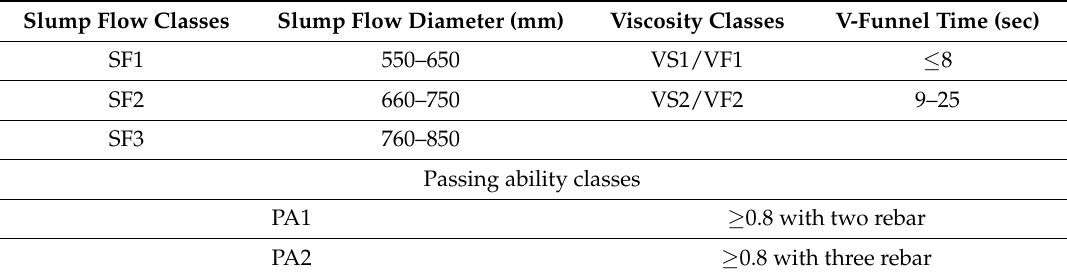
Table 3. Recommendations of European Federation of National Associations Representing for